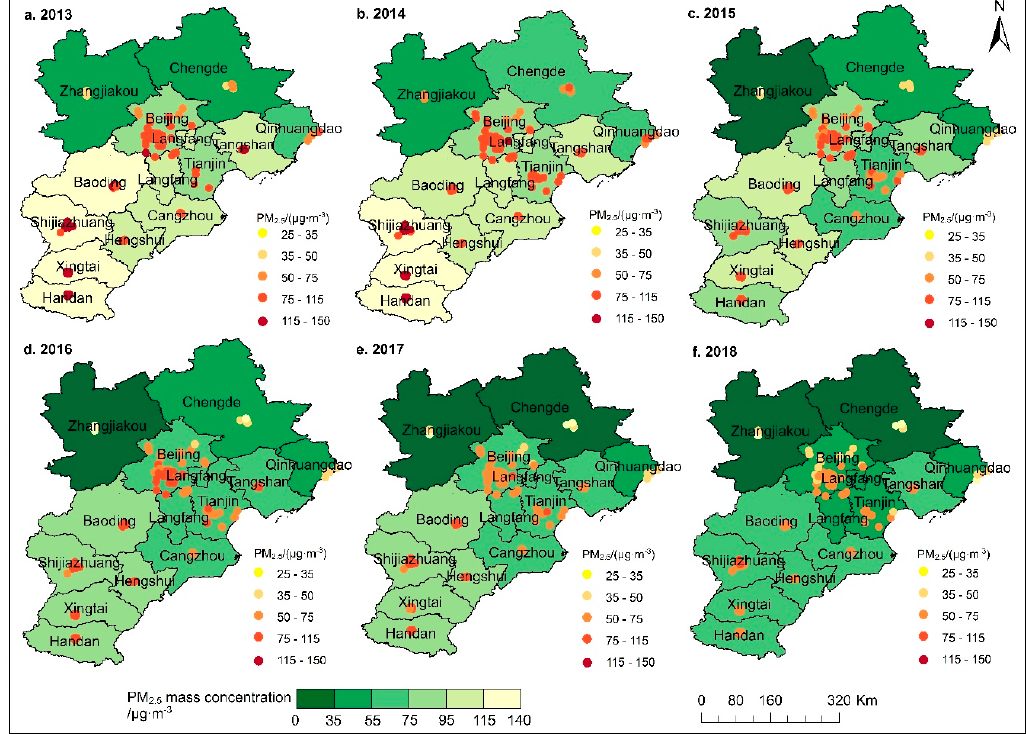
Figure 6. Spatial characteristics of annual PM 2.5 mass concentration of BTH from 2013–2018.